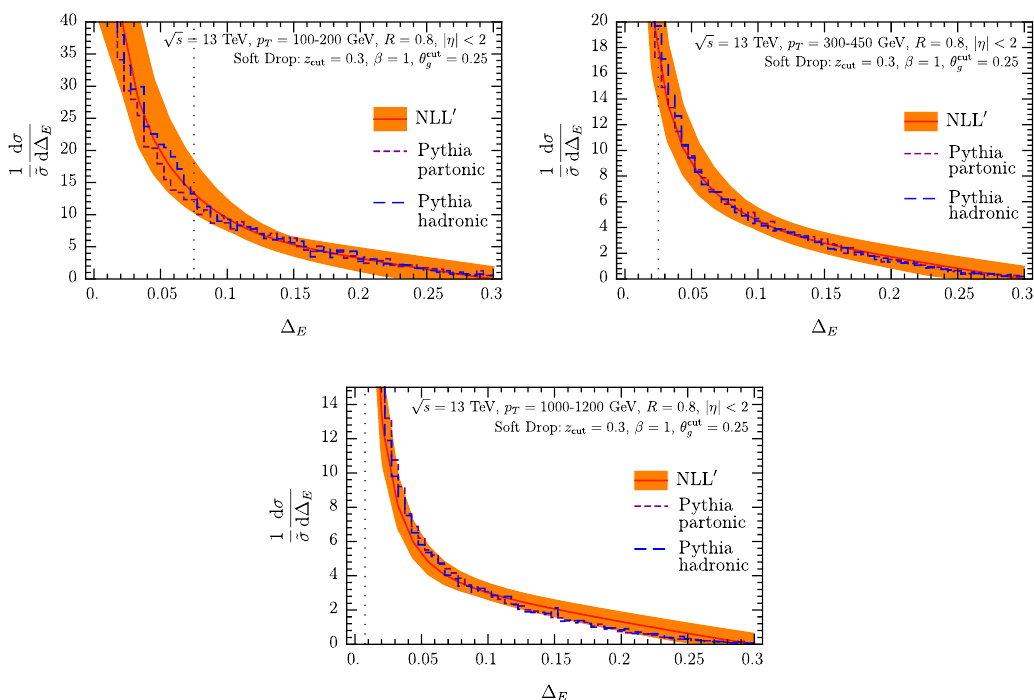
Figure 16 . Numerical results at NLL 0 (orange) for the jet energy drop for soft drop with z cut = 0 . 3 , β = 1 and θ cut = 0 . 25 . In addition, we show Pythia results at parton (purple dashed) and hadron g level (blue dashed) for comparison. The different panels correspond to different jet transverse momenta. The central curves are normalized to unity between the dotted vertical line and the endpoint ∆ E = z cut